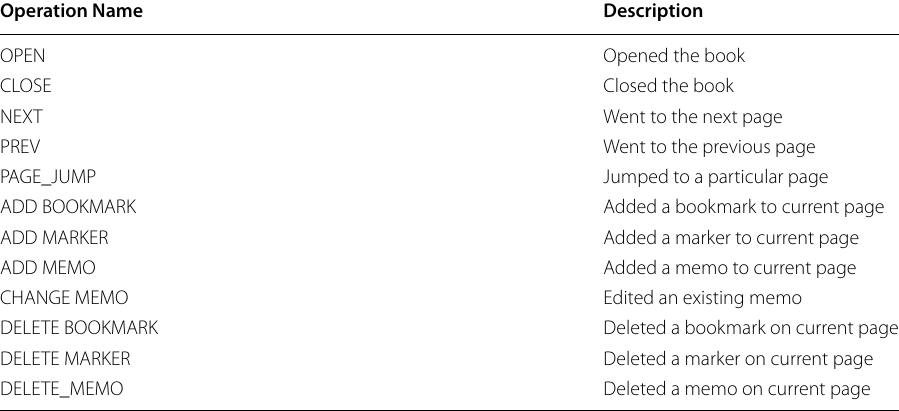
Table 2 Operation names and descriptions for learning behavior interactions captured with